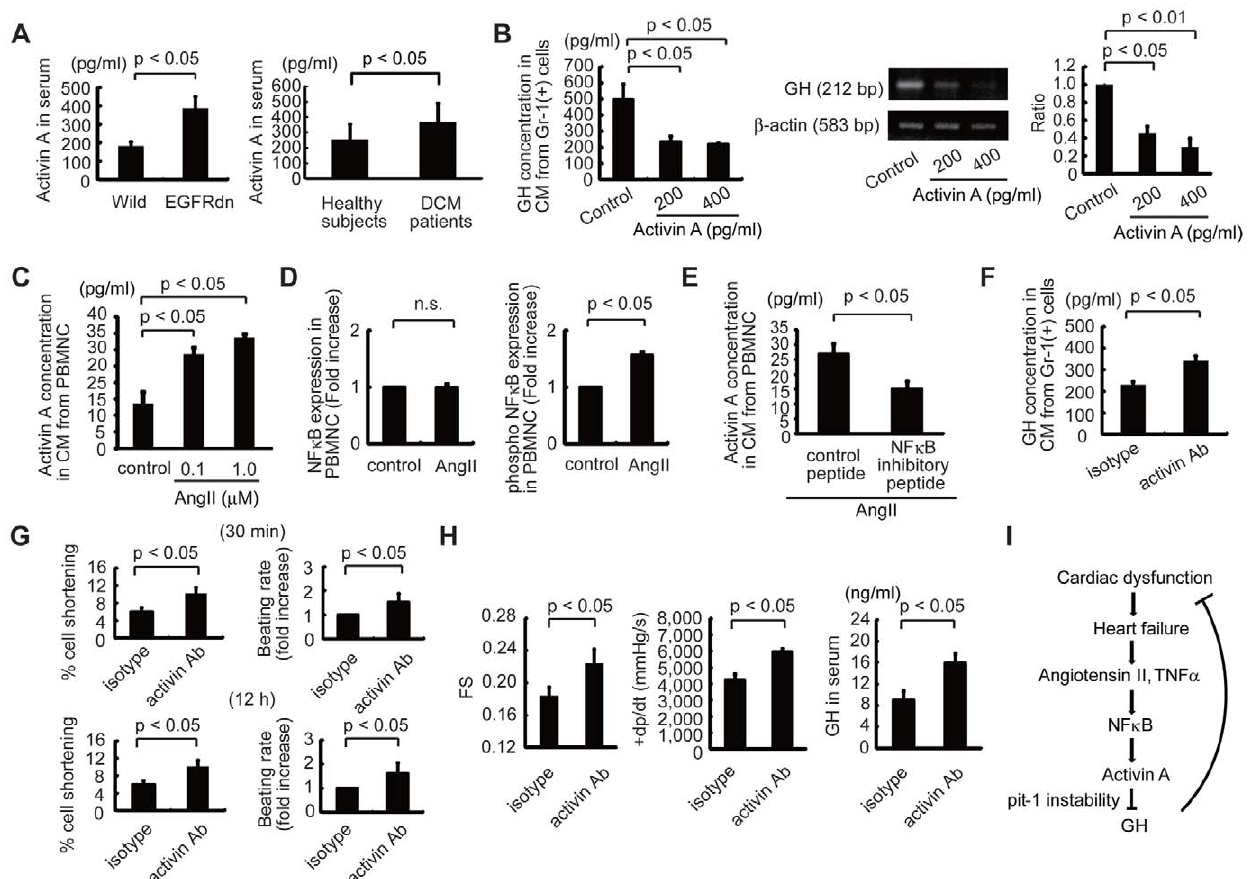
Figure 6. Regulatory mechanisms of GH in heart failure. (A) The serum activin A concentration was higher in EGFRdn mice (left, n =5) and in DCM patients (right, n =10) than in wild-type mice ( n =5) and healthy subjects ( n =11). (B) Activin A downregulated GH mRNA expression in Gr-1( + ) cells and GH protein levels in Gr-1( + ) cell CM. Left graph, GH protein concentration; middle photographs, representative semi-quantitative RT-PCR images; right graph, GH mRNA expression ( n =3). (C, D) AngII upregulated activin A secretion (C, n =4) and phosphorylated NF k B expression (D, n =5) in wild-type PBMNC. (D) Left graph, total NF k B; right graph, phosphorylated NF k B. (E) Inhibition of NF k B [50 m M; NF k B p65 (Ser276) inhibitory peptide] suppressed AngII (10 m M)-mediated upregulation of activin A in CM derived from wild-type PBMNC ( n =5). Isotype peptide was used as control. (F) The GH concentration in CM from EGFRdn Gr-1( + ) cells ( n =5) was significantly increased by treatment with an anti-activin A antibody ( n =5). (G) Effects of anti-activin A antibody treatment on cell shortening and the beating rate of cardiomyocytes induced by CM from Gr-1( + ) cells isolated from EGFRdn mice ( n =18 cells per group). (H) Treatment with the anti-activin A antibody improved the cardiac function of EGFRdn mice. Left graph, echocardiography ( n =7). Middle graph, miller catheter results ( n =7). Right graph, serum GH concentration in EGFRdn mice after antibody treatment ( n =7). Data are means 6 s.e.m. (I) Proposed mechanism underlying impaired GH expression by activin A in heart failure.